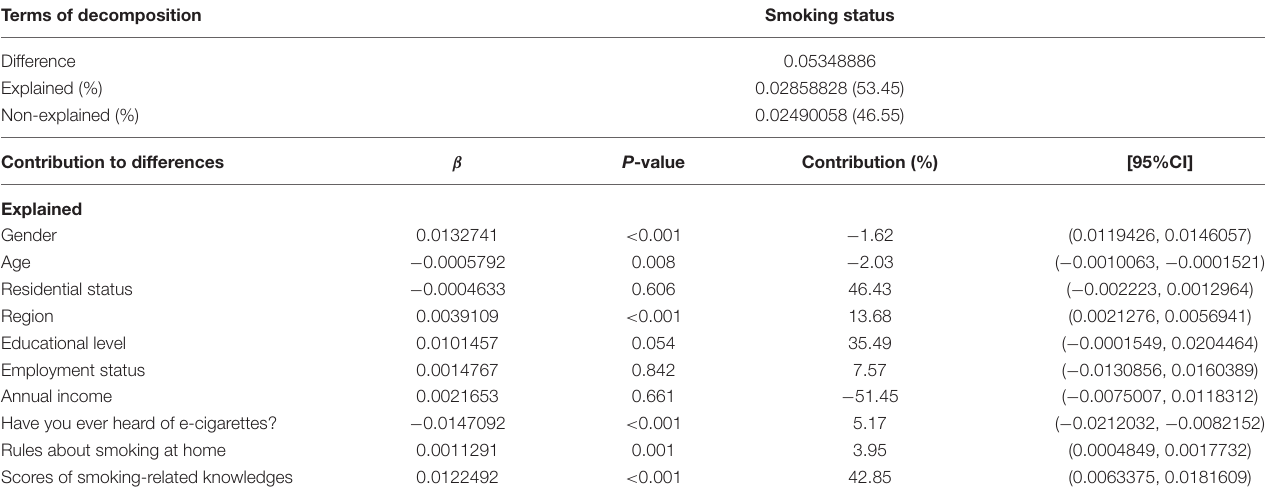
TABLE 8 | The Fairlie decomposition model of smoking status between urban and rural. Terms of